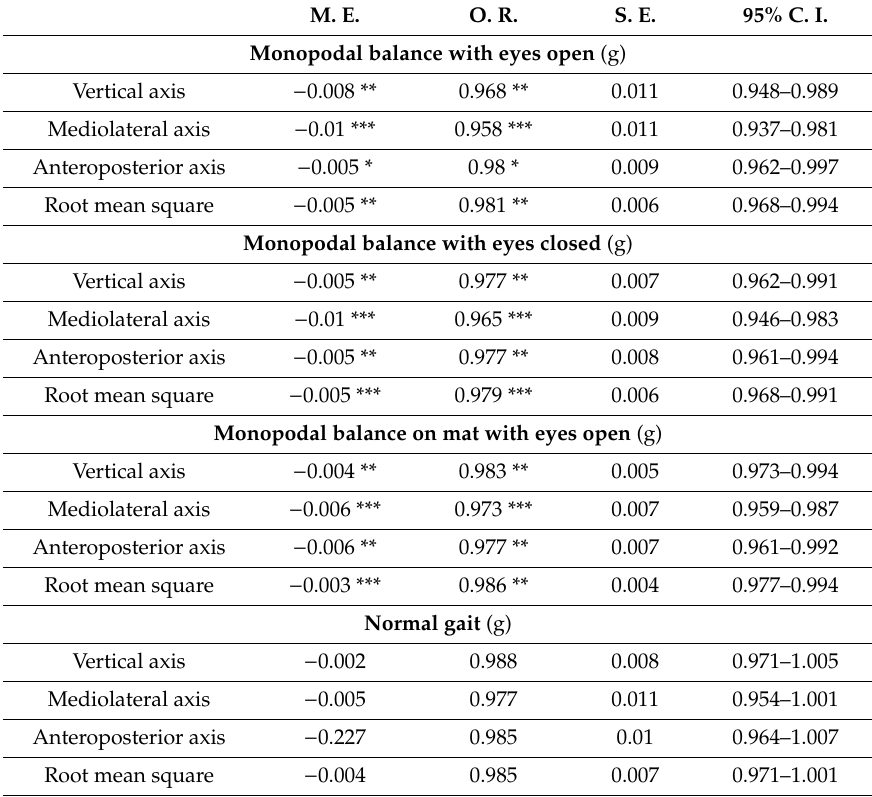
Table 4. Logistic regressions for sex adjusted for age and physical activity